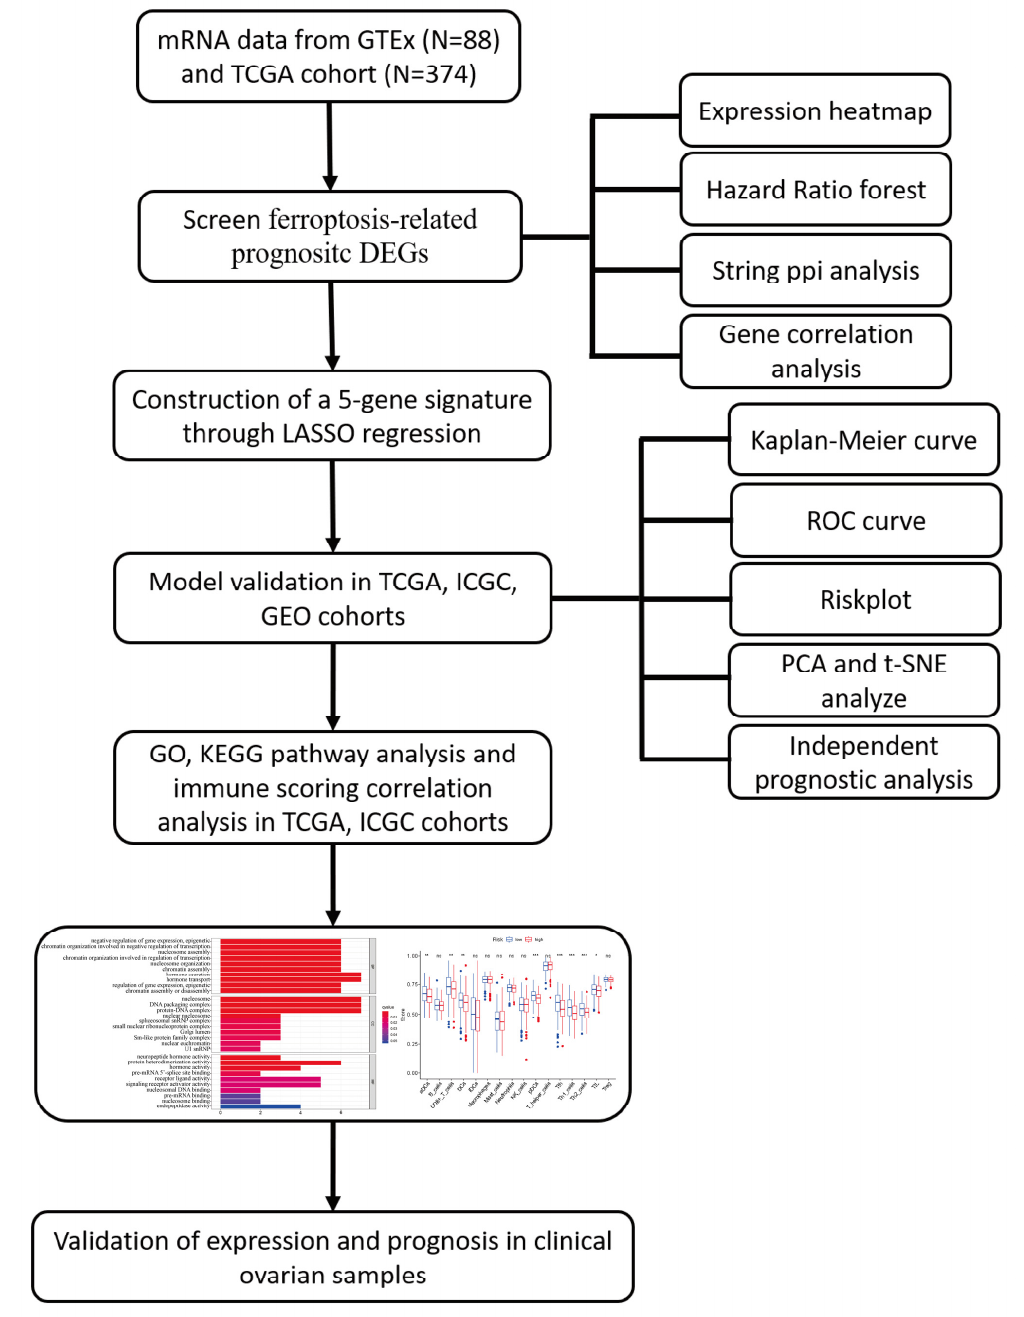
Figure 1. Workflow diagram of data collection and analysis (* p < 0.05, ** p < 0.01, *** p < 0.001).